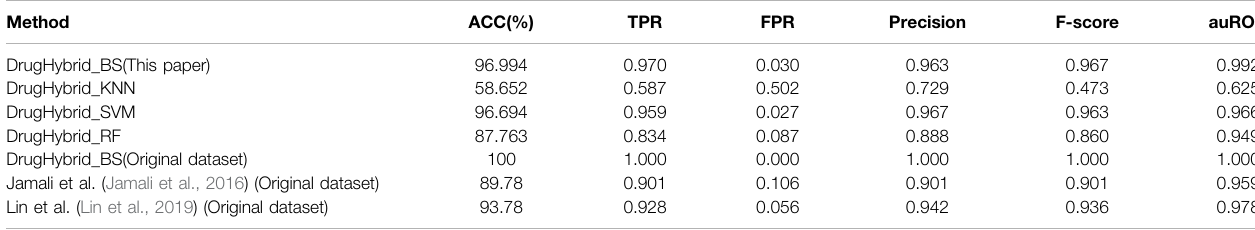
TABLE 6 | Comparison of prediction performance with other algorithms. Method